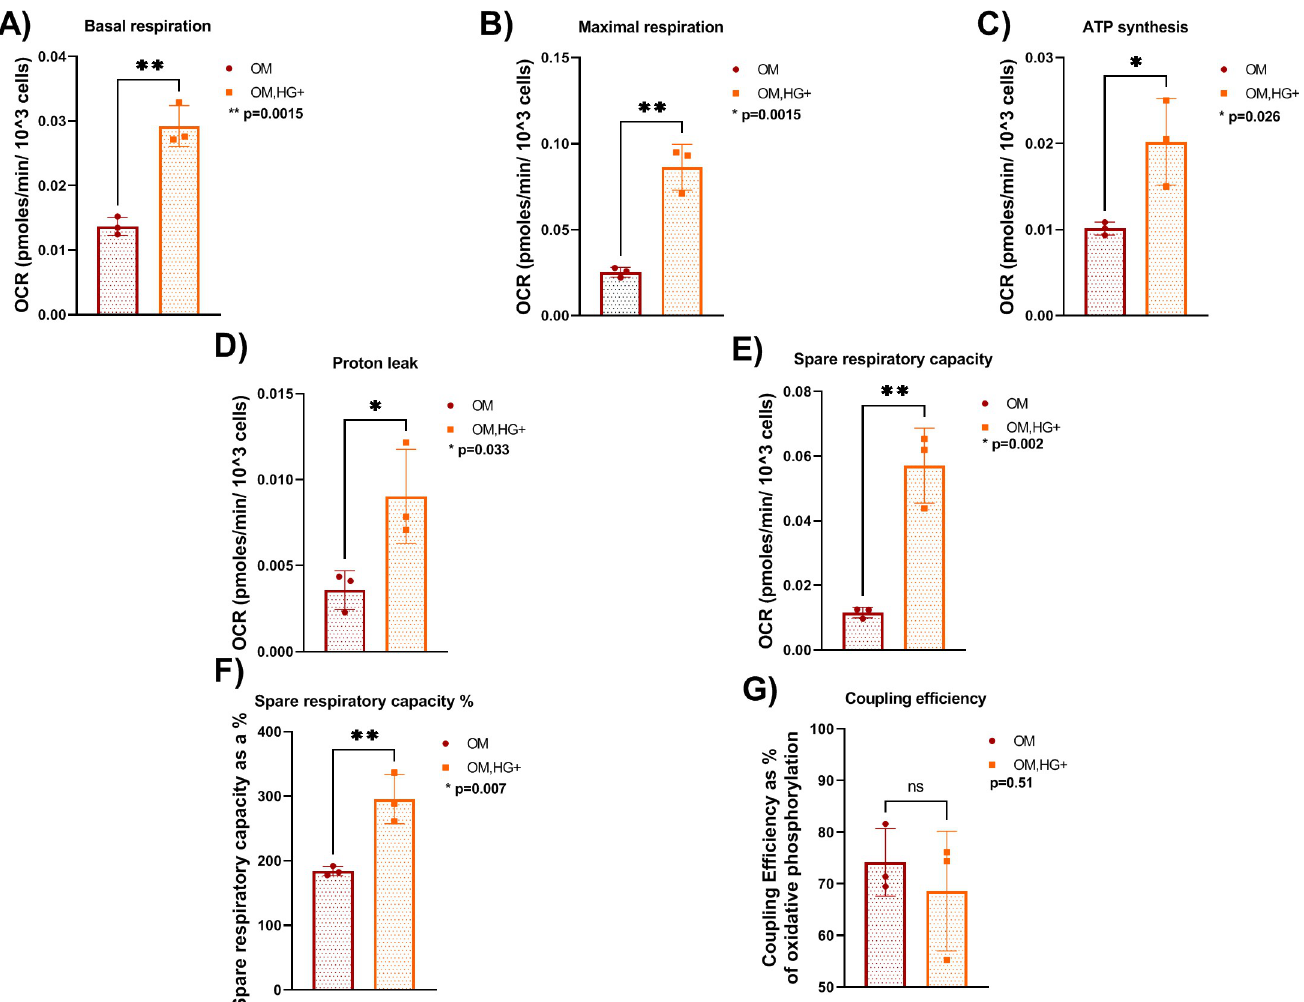
Fig 5. Fundamental parameters of mitochondrial respiration are elevated in HG-treated bone cells. A. Basal respiration. B. Maximal respiration. C. ATP synthesis. D. Proton leak. E. Spare respiratory capacity. F. Spare respiratory capacity %. G. Coupling efficiency. Error bars indicate SD (standard deviation). Data were analyzed using Student T-test. A total of N = 3 independent experiments per culture condition were performed. All experiments were performed in